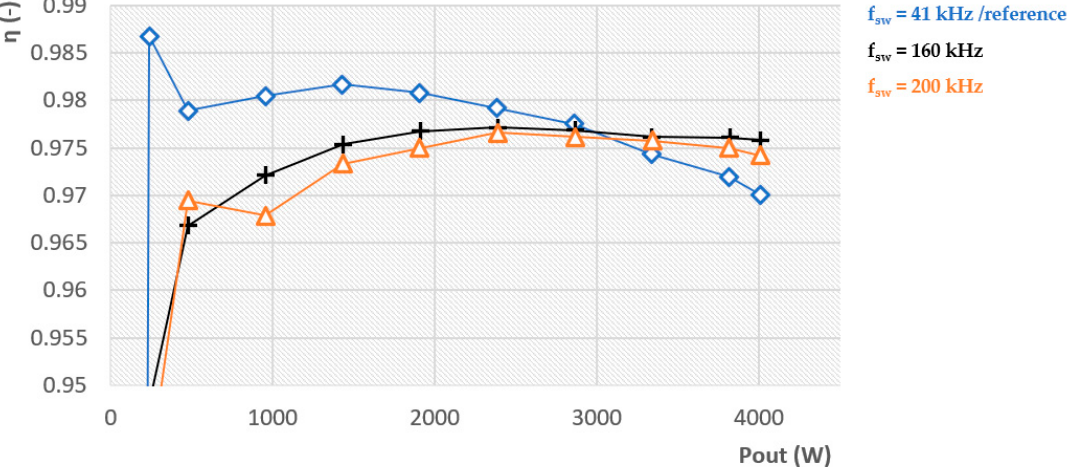
Figure 11. Efficiency characteristic of PFC converter equipped with TP65H050WS GaN transistor in dependency on the output power and switching frequency (blue line—referenced non-optimized solution).